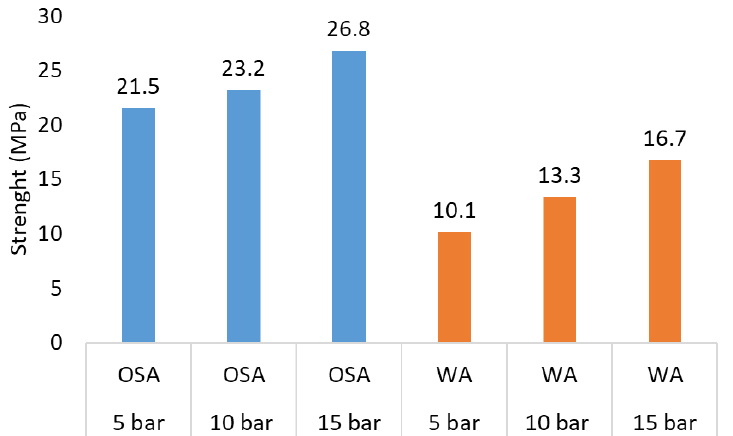
Figure 9. Compressive strength values at different curing pressures (100% CO 2 , 25 °C, 150 kg/cm 2 ) (Average values obtained from min. 4 samples (std. deviation < 3%)).